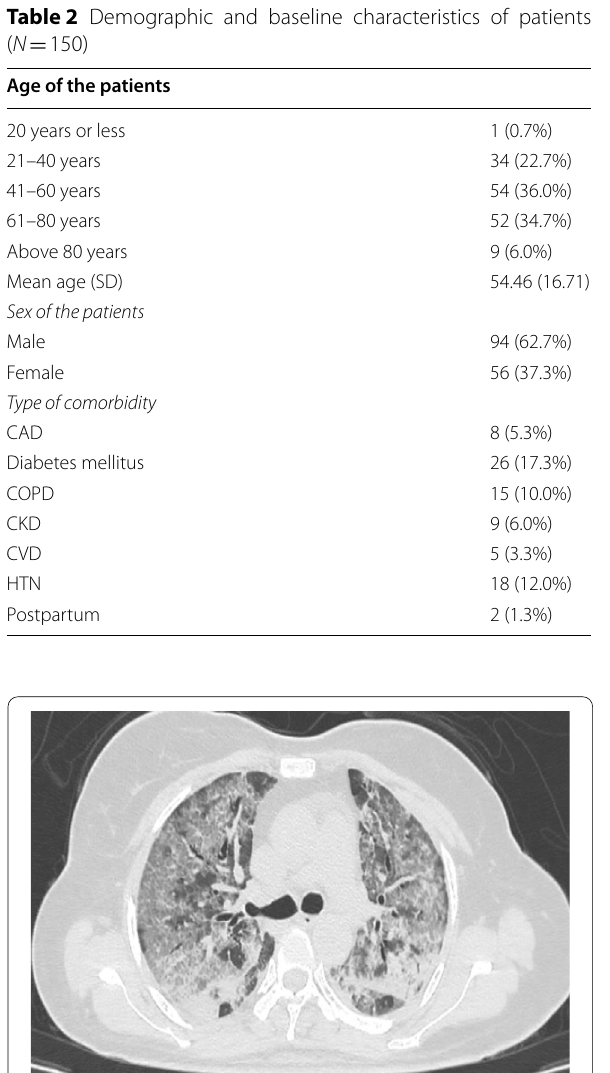
Table 3 Distribution of cases according to